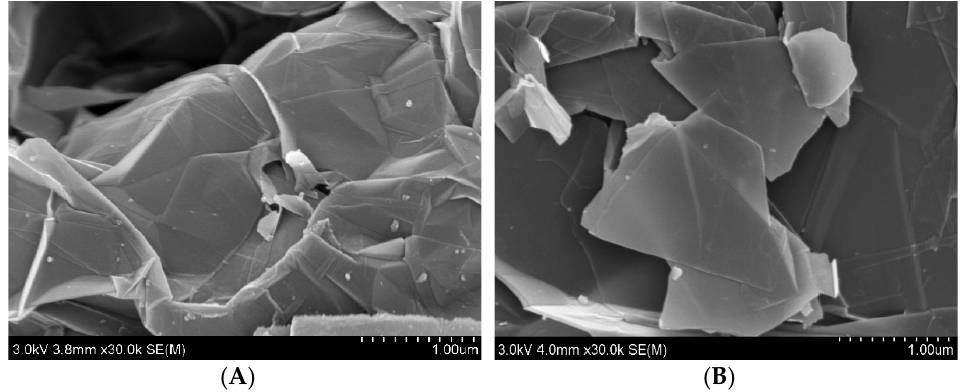
Figure 2. Expanded graphite and MEG 30,000× magnification. ( A ) Expanded graphite; ( B ) MEG.